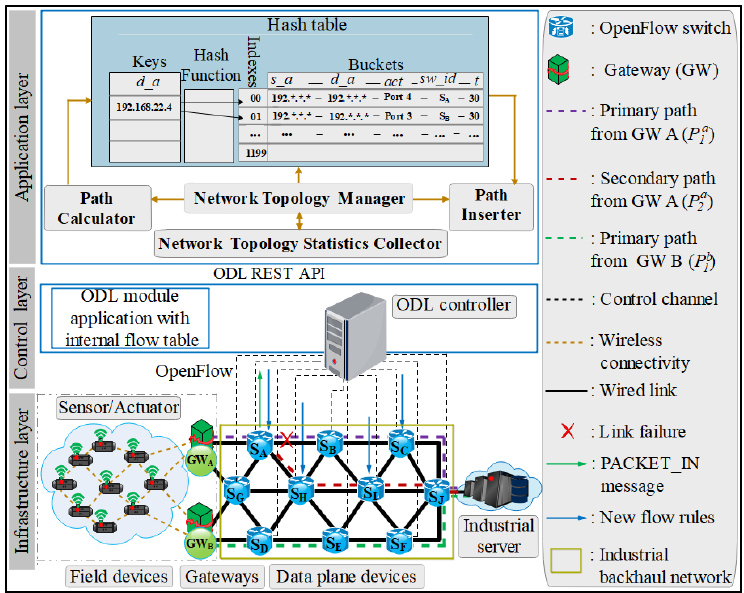
Figure 6. Network topology upgrading scenario with a link